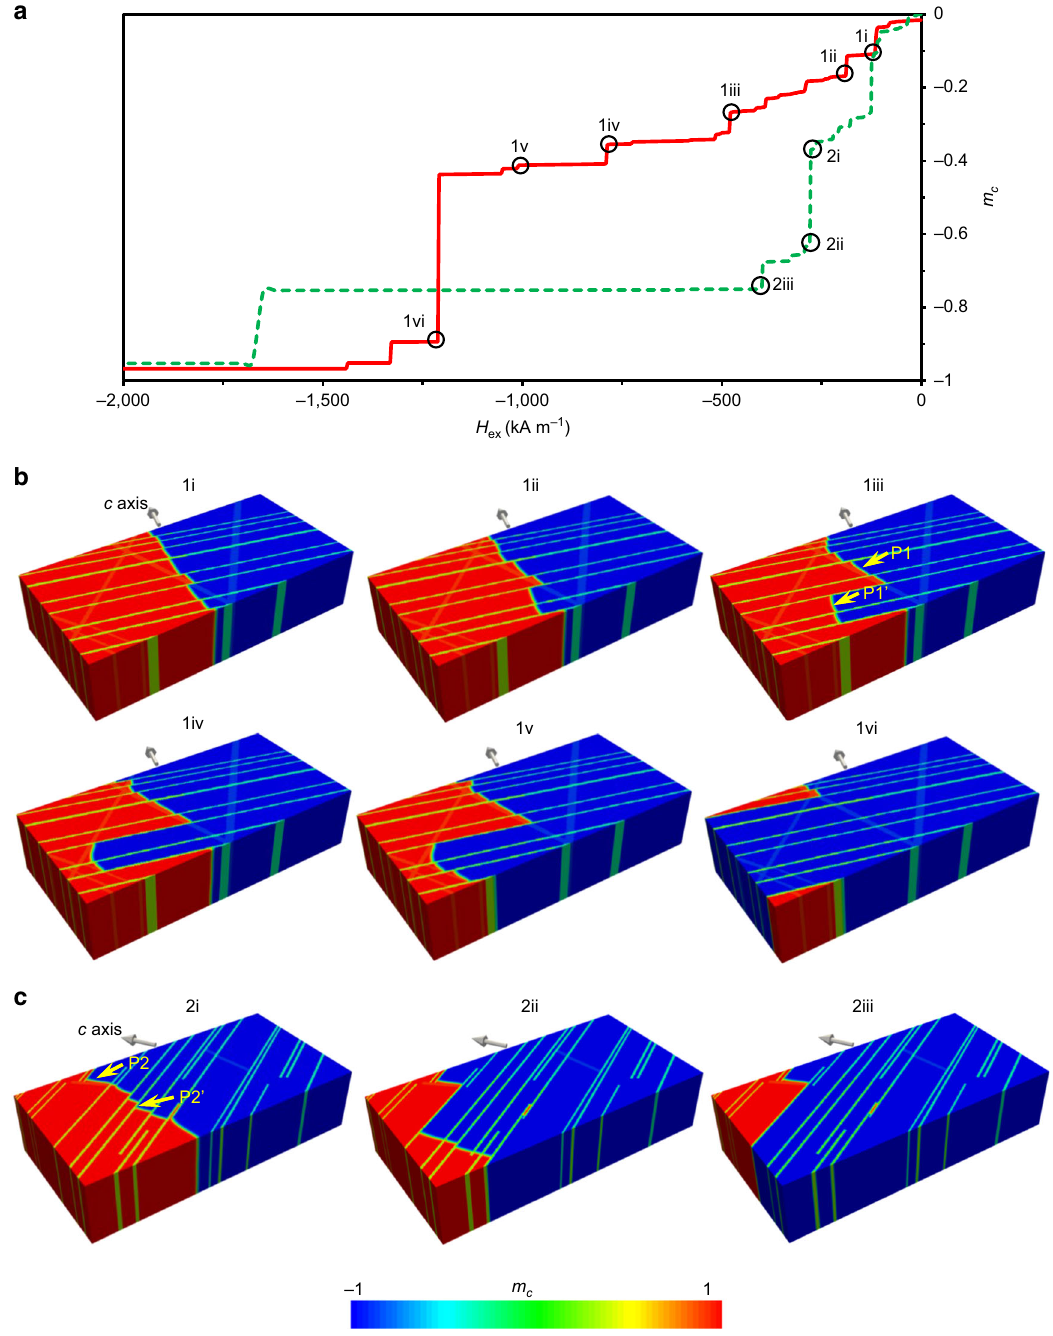
Fig. 3 Simulation results on domain wall pinning. a Demagnetization curves with the red and green lines corresponding to samples 1 and 2, respectively. The magnetization reversal process of b sample 1 and c sample 2 at different values of applied external magnetic fi eld marked in a . m c denotes the magnetization component along the easy axis. P1 and P2 show typical pinning sites, where 1:5 phase intersects with the Z-phase. P1 ′ and P2 ′ denote typical sites containing only the Z-phase. The yellow arrows denote the